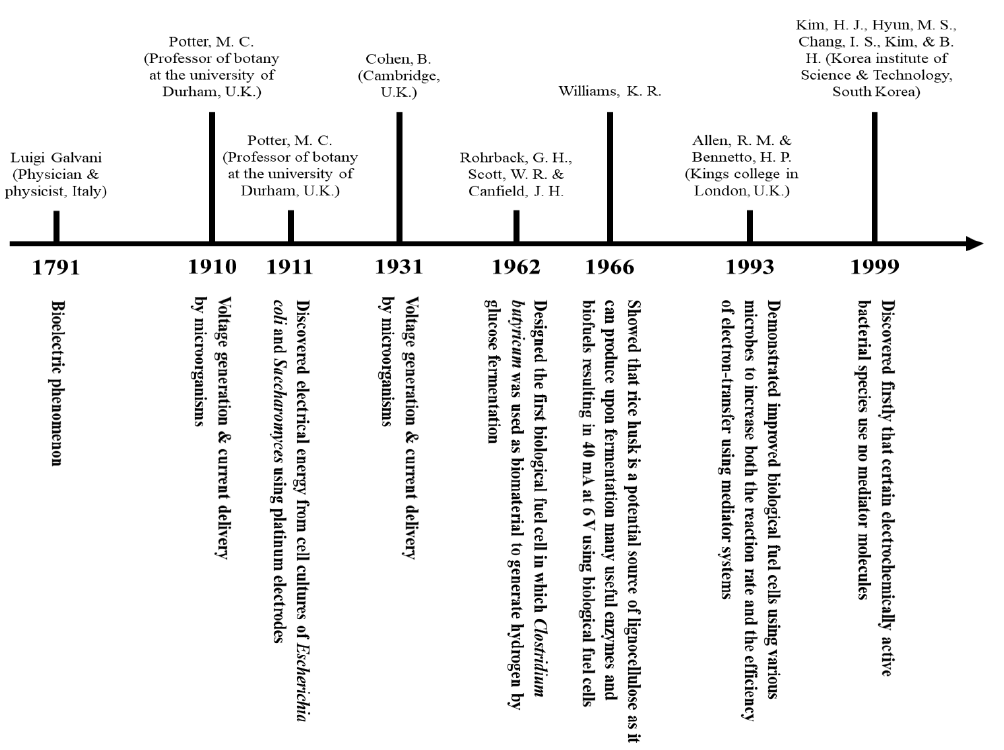
Figure 1. History of discovery of bioelectrochemical systems.